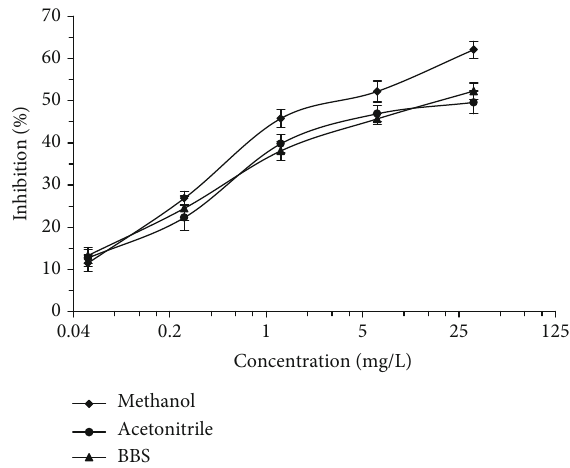
Figure 3: E ff ect of preparation solutions on the BELISA method.